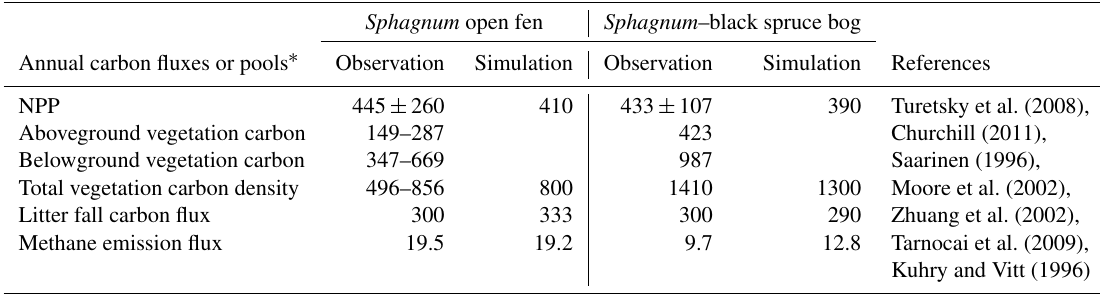
Table 2. Carbon pools and fluxes used for calibration of CMDM.